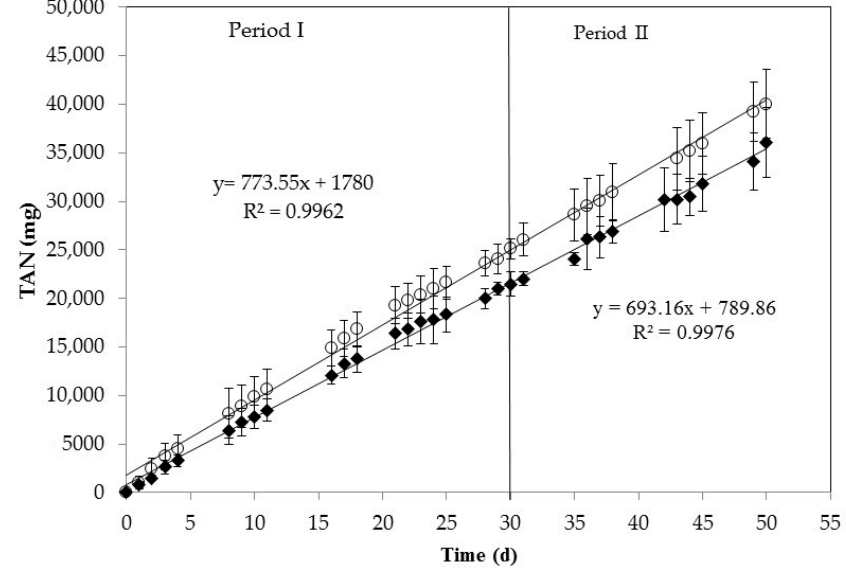
Figure 3. Mass of TAN removed from swine manure ( ) and recovered in the acid tank ( ). Linear equations and R 2 are represented. The error bars represent the standard deviation of duplicate experiments. Table 2. Nitrogen mass balance for the system for Period I and Period II.